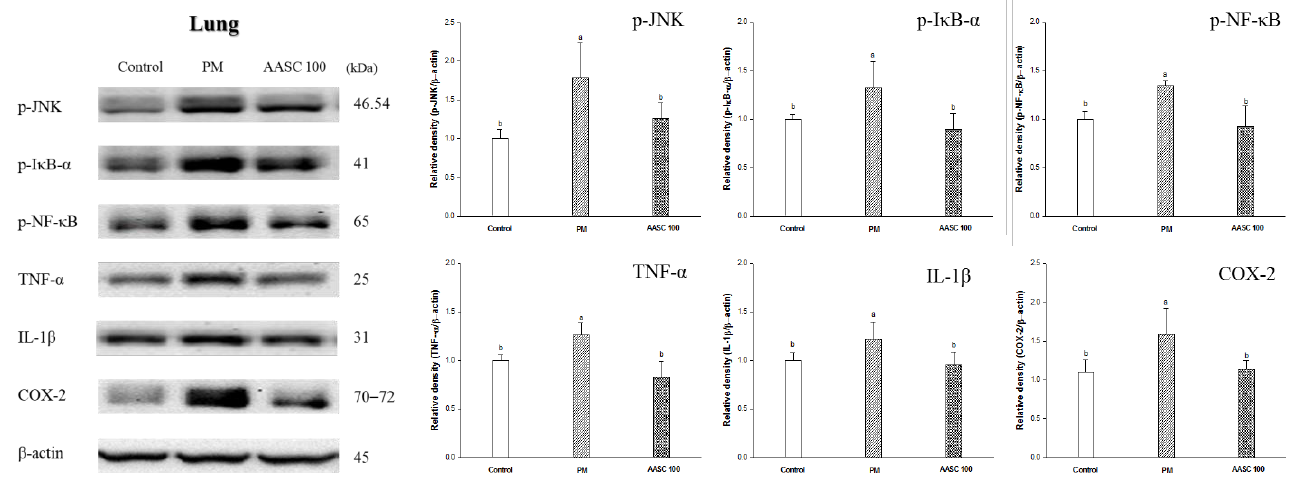
Figure 4. The effect of AASC on proteins related to inflammation in lung of mice exposed to PM 2.5 . Results are indicated as mean ± SD ( n = 8). Different small letters represent the statistical difference ( p < 0.05) of each group in a high order.